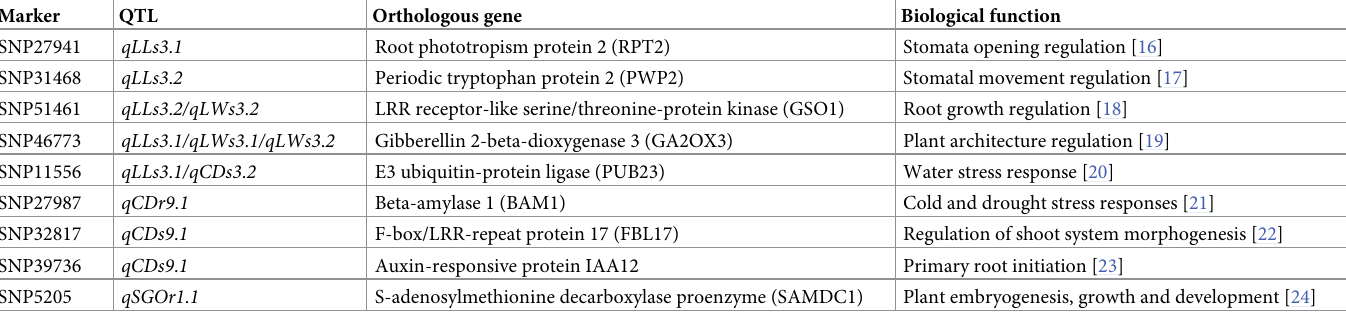
Table 3. Identification of candidate genes within QTL intervals associated with drought tolerance and plant morphology in St. Augustinegrass.